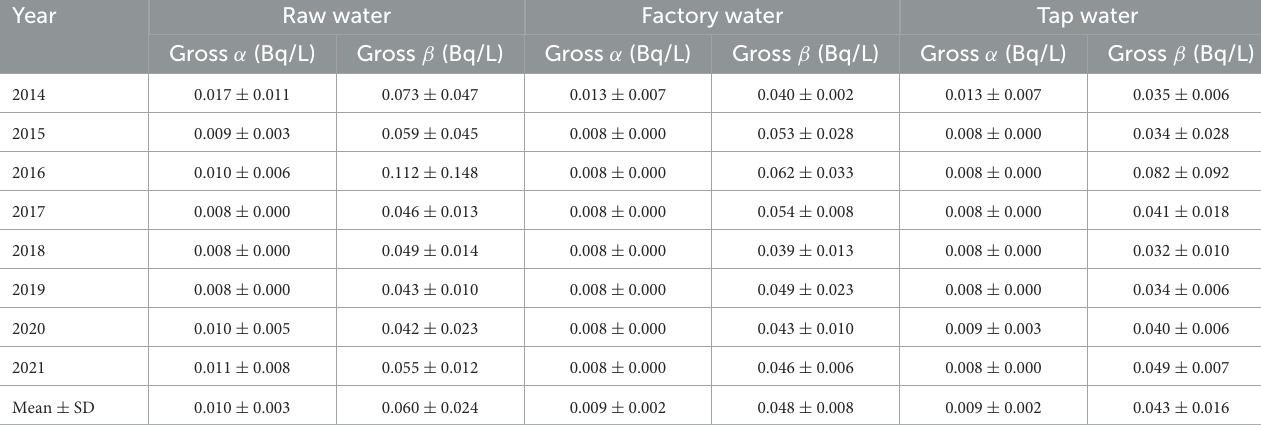
TABLE 2 Radioactivity of gross α and gross β in three types of drinking water around SNPP from 2014 to 2021.